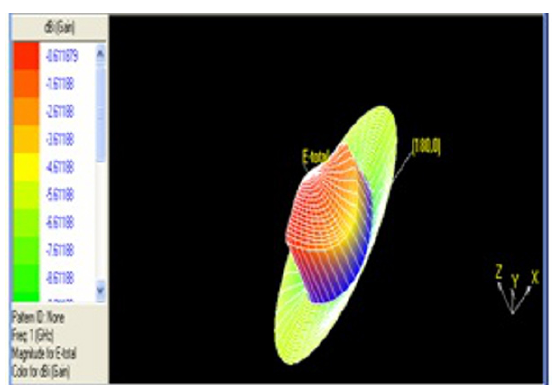
Figure 7. 3D radiation pattern plot of slotted microstrip antenna.